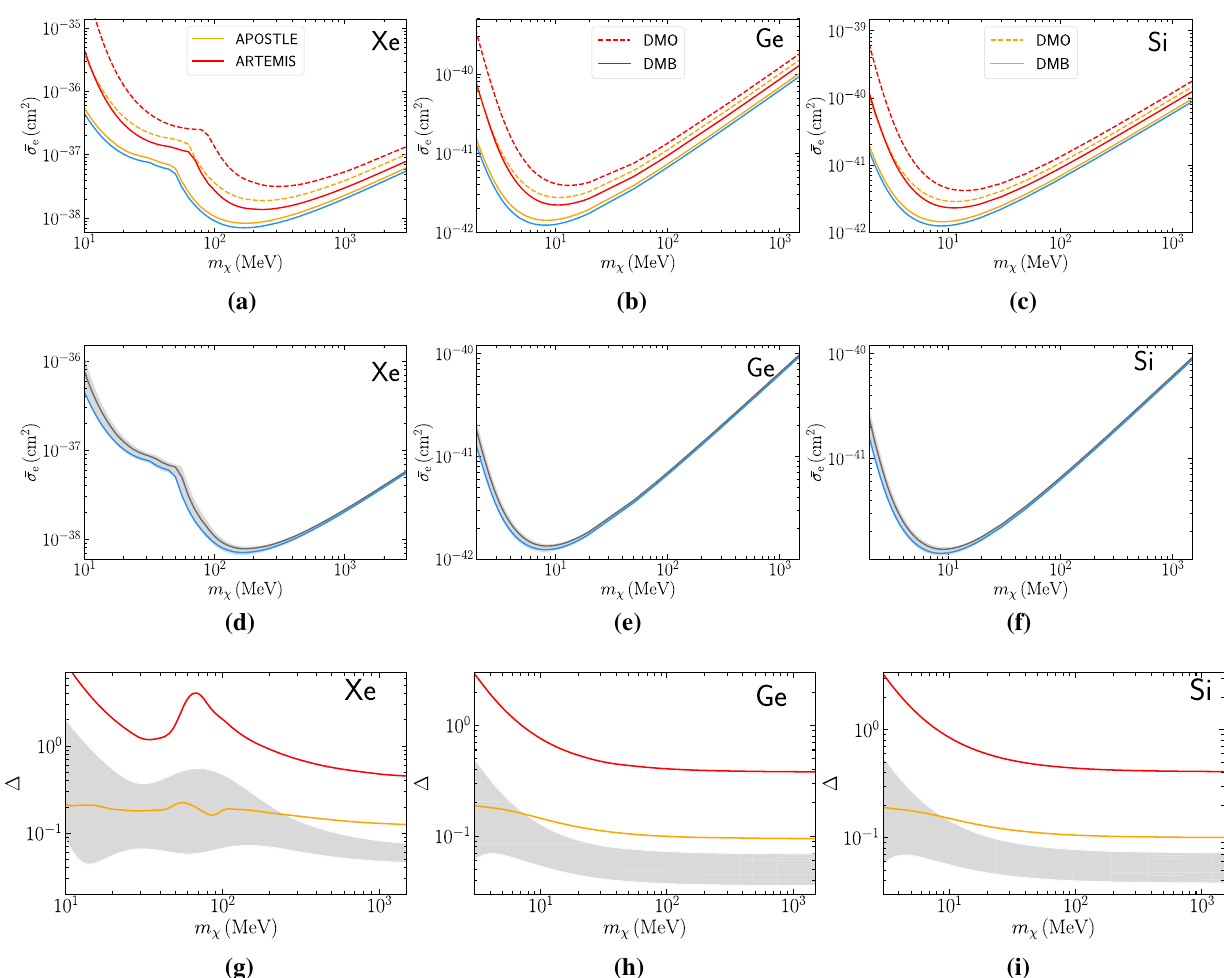
Fig. 6 Variations in the exclusion bounds for Mao et al. with a representative value of p = 2 . 7 for F DM = 1. All other relevant details are same as of Fig.